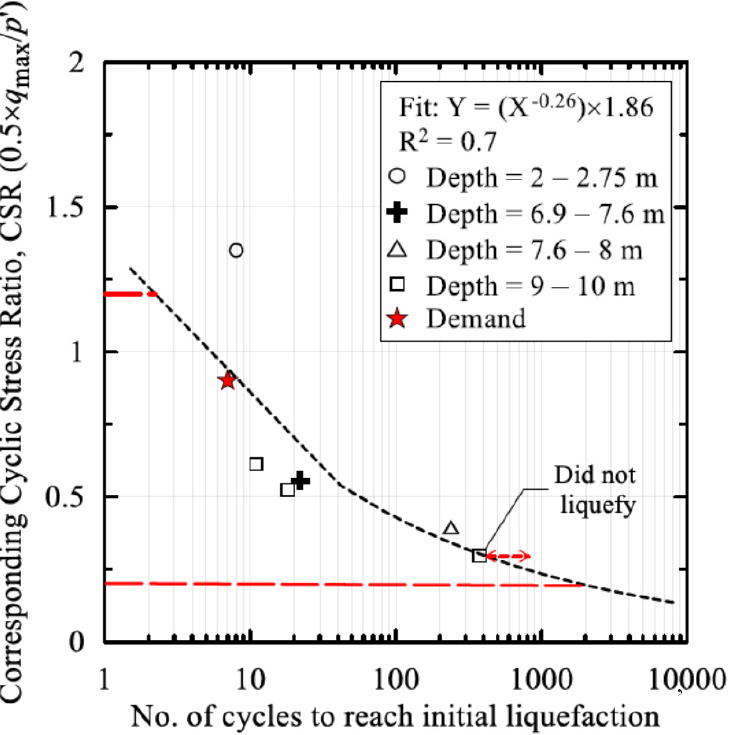
Figure 13. Undrained cyclic triaxial shear strength test results for soil specimens from Site 2-1 (after Anderson et al. [46]).